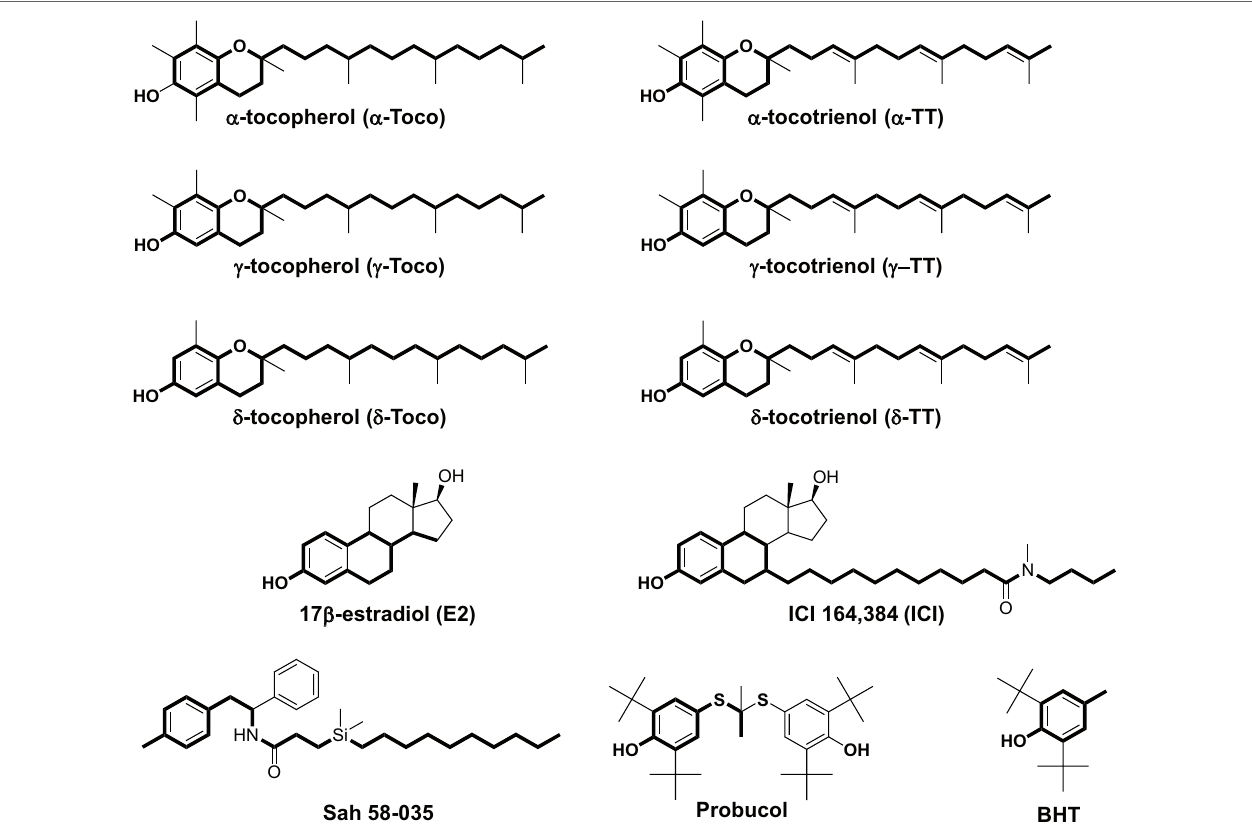
FigUre 1 | chemical structures of α -, γ -, and δ -tocopherol; α -, γ -, and δ -tocotrienol; 17 β -estradiol; ici 164,384; sah 58-035; probucol; and butylated hydroxytoluene (BhT) . Boldface type indicates the part of the molecules that are